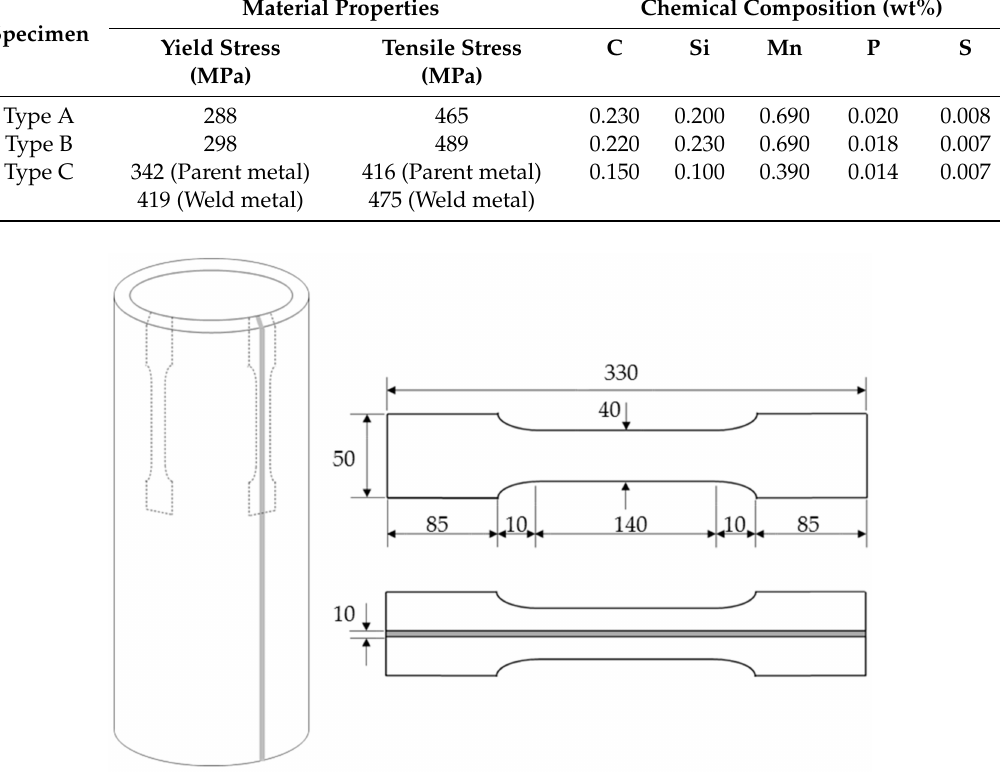
Figure 3. Tensile test specimen (units: